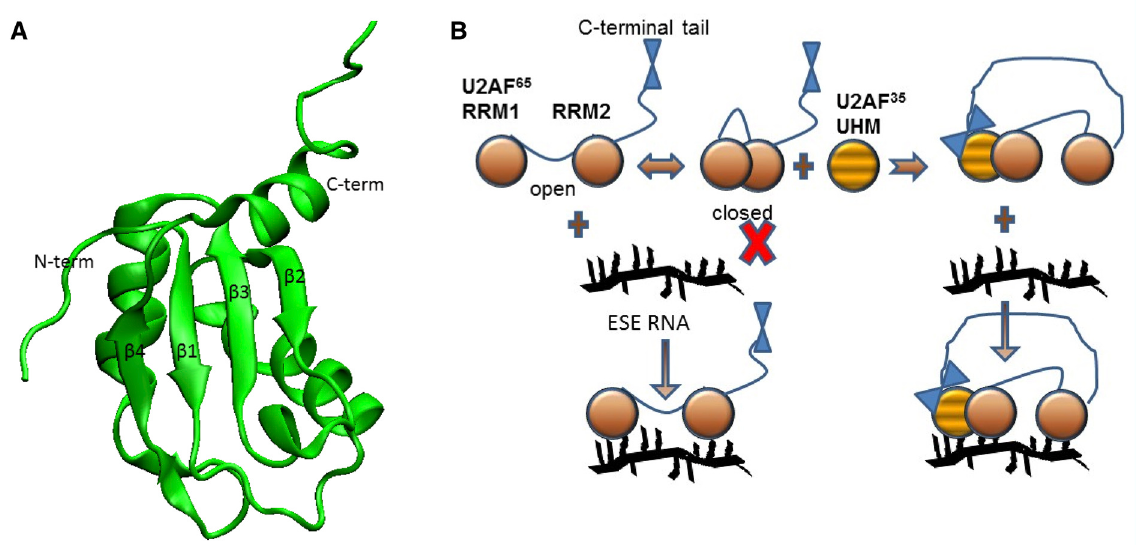
Figure 2. Regulation of RNA recognition motif (RRM) binding to RNA. A . An RRM has a four-stranded anti-parallel β -sheet, with two α -helices on one side 92–95 . RNA often sits on the surface of the β -sheet. B . The two RRMs of U2 auxiliary factor (U2AF) exhibit closed/open transitions at equilibrium, but only in the open state can RNA bind. Binding of the U2AF homology motif (UHM) from U2AF35 to RRM1 shifts the equilibrium to favor the open state, which facilitates RNA binding. The C-terminal tail of U2AF65 contacts the U2AF35 UHM. ESE, exonic splicing